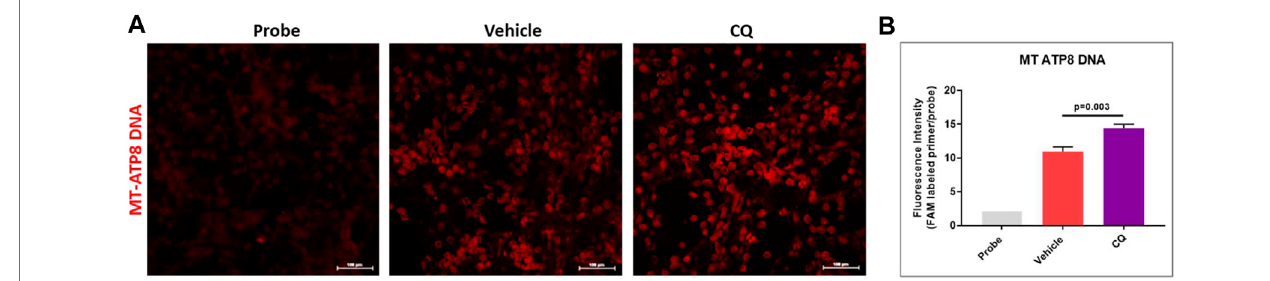
FIGURE 8 | Effect of CQ on mitochondrial DNA in kidneys. (A) , representative in situ PCR images vehicle and CQ treated rat kidney tissues after 120 min of resuscitation. Probe represents the negative control (background fl uorescence) of the in situ PCR reaction. Red fl uorescence indicates ampli fi ed MT-ATP8 DNA